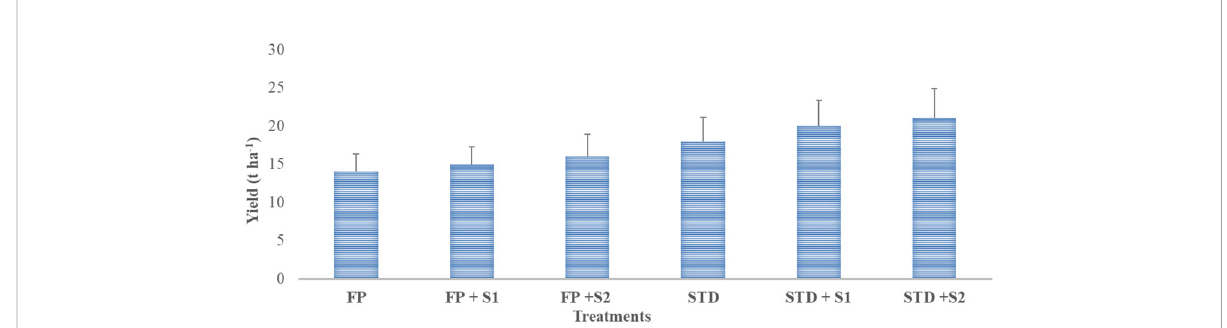
FIGURE 5 In fl uence of nutrient management practices on yield of French beans in farmers ’ fi elds. T-shaped bar at the top of each bar indicates standard error (SE), and different letters on top indicate statistical difference (Duncan ’ s multiple-test range), p =